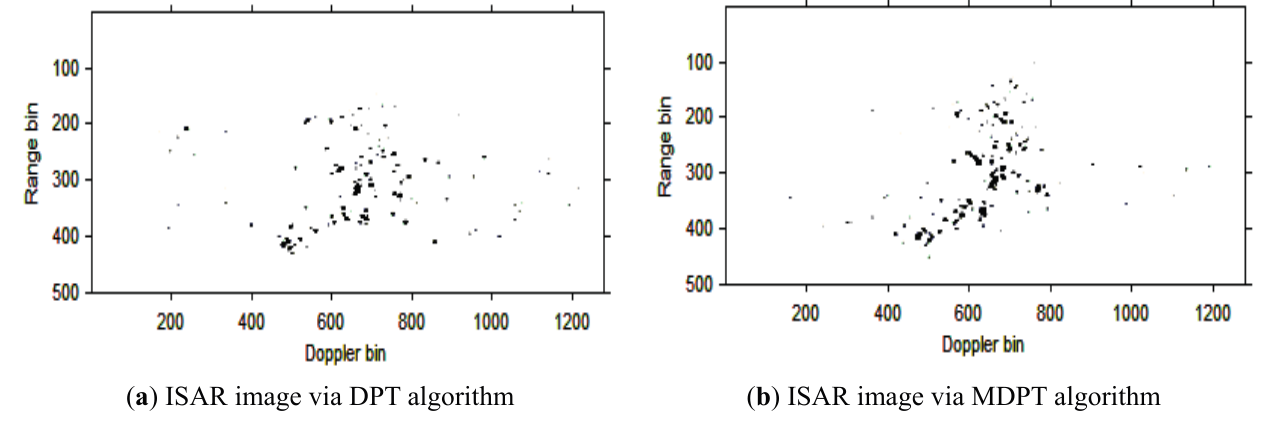
Figure 7. ISAR images at time t = 0.60 s based on DPT and MDPT algorithms.